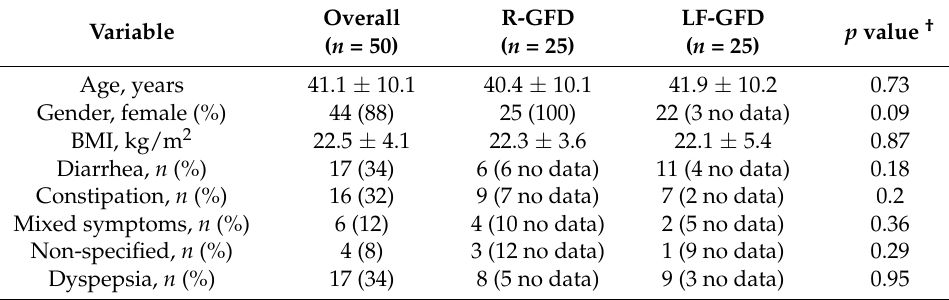
Table 2. Background and gastrointestinal symptoms at baseline 1 .